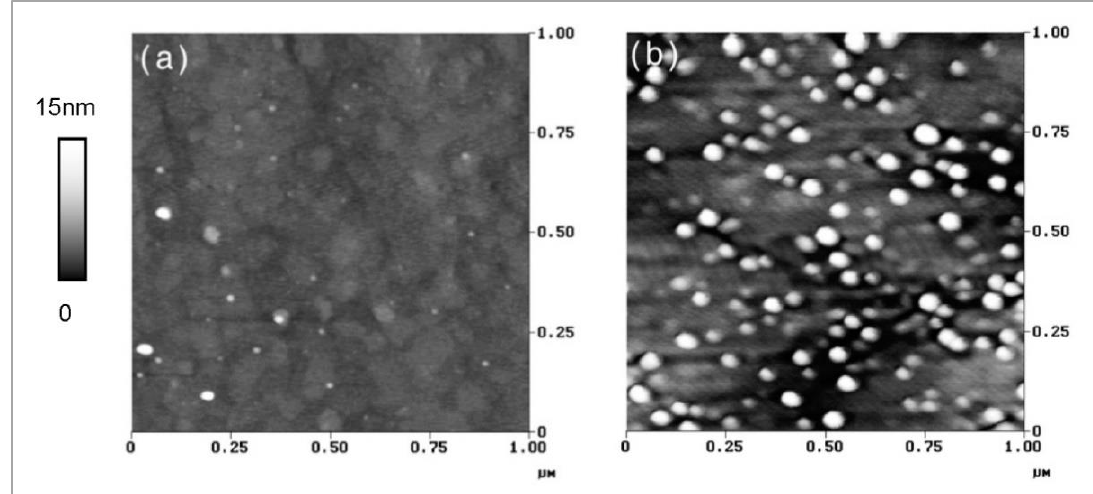
Figure 3. AFM topography maps of 3 nm (about 2.6 pure InAs equivalent ML) In x Ga 1−x As layers with x = 0.24 ( a ) and x = 0.25 ( b ). Reproduced with permission from [11].